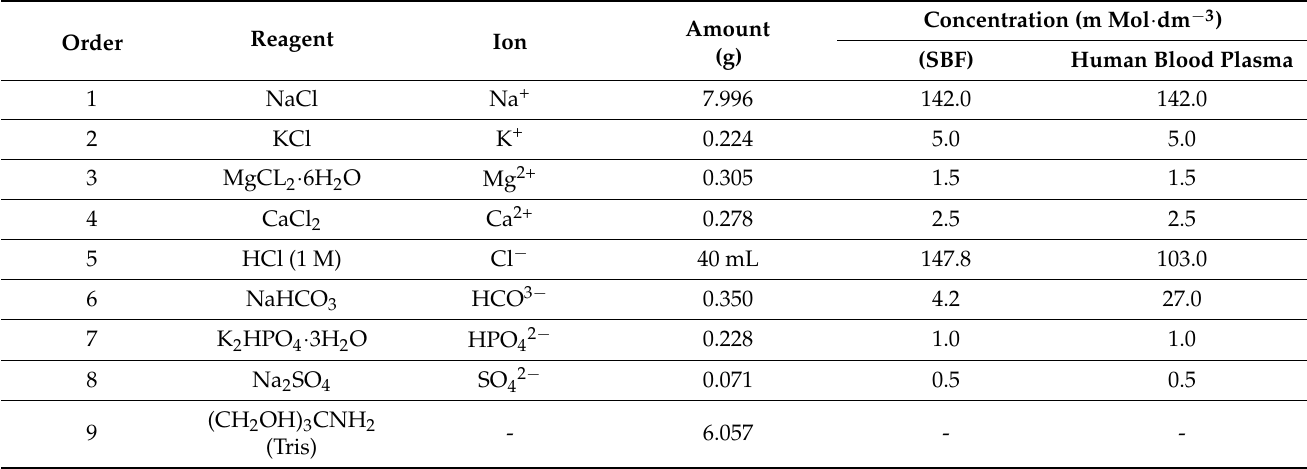
Table 1. Ion concentrations of prepared SBF (simulated body fluid) and human blood plasma (1 L).